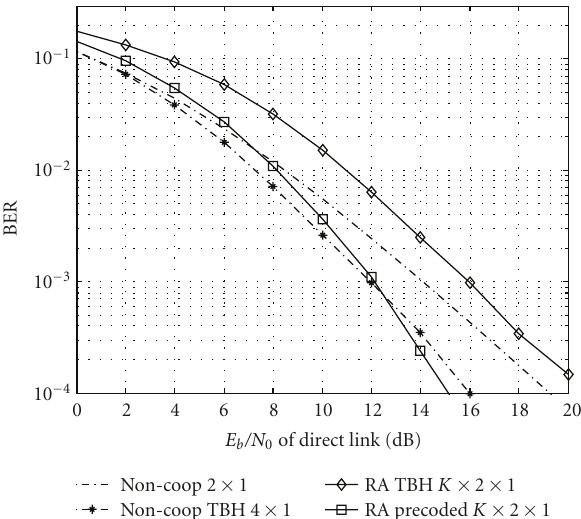
Figure 13: BER of cooperative systems with 2 antennas per relay and of reference systems for Scenario 1.